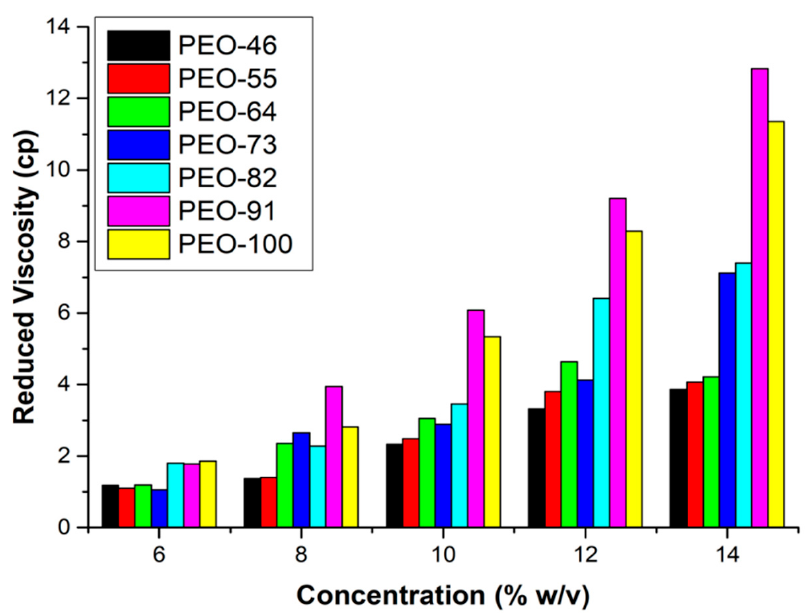
Figure 1. Viscosity of the PEO solutions as a function of concentration and composition of the solvent mixture.